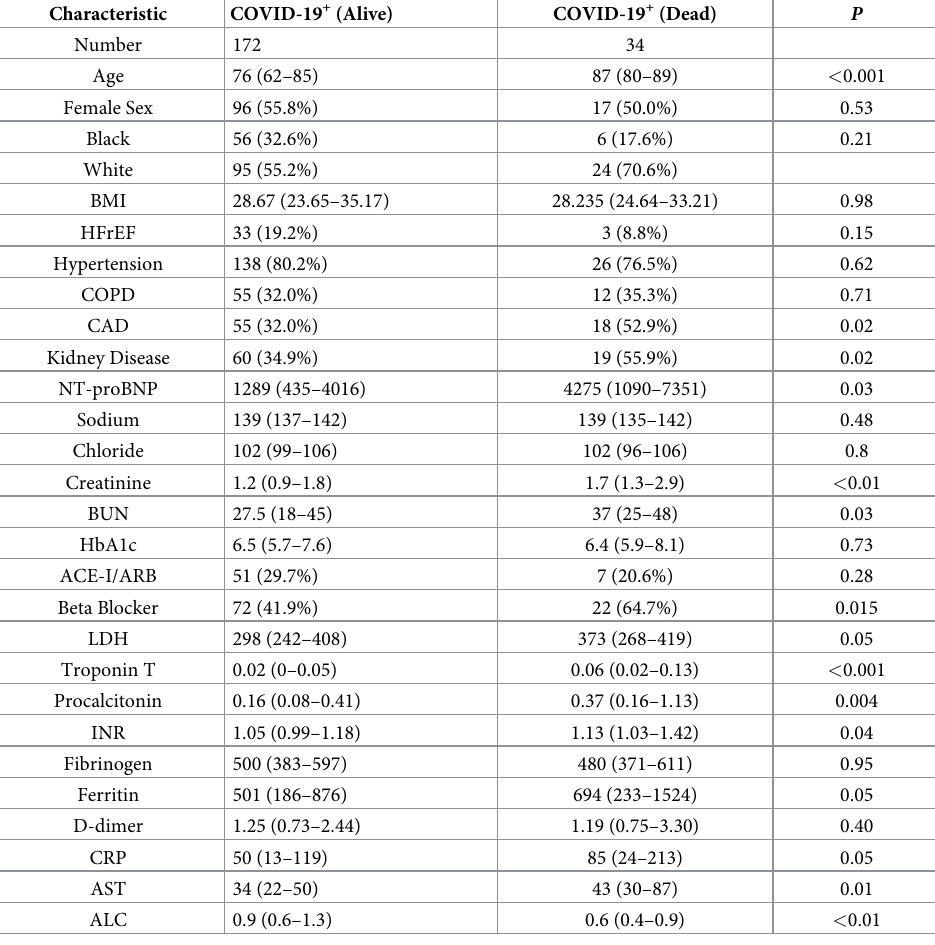
Data are presented as median (IQR) for continuous measures, and n (%) for categorical